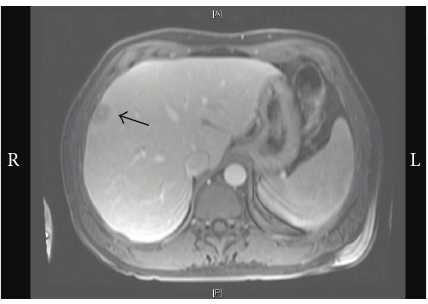
Figure 1: Magnetic resonance of abdomen showing two lesions within the right lobe of the liver along the peripheral surface (black arrows).